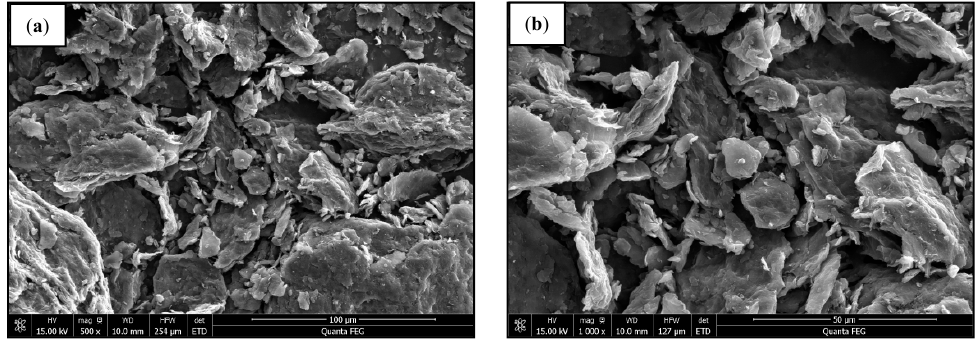
Figure 1. SEM pictures of GO (( a ) 500×; and ( b ) 1000×).